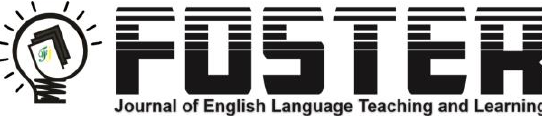
Table 9. The Mean Score and Standard Deviation of Students’ Pretest and Posttest N Std. Deviation